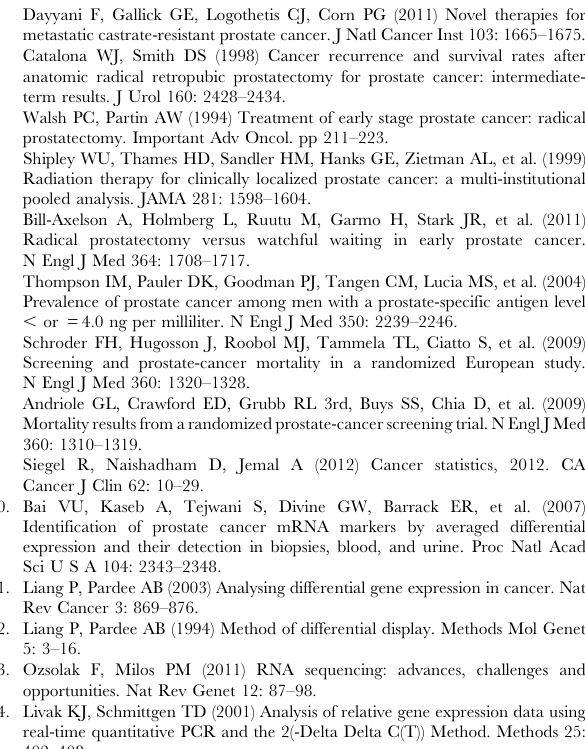
Table S1 Raw C T data are presented for the validation cohorts of prostate cancer patients (PrCa pts) and healthy controls. Mean C T values were lower in PrCa pts compared to controls (28.25 vs. 29.50, p= 0.02). Mean C T values for the 18S reference gene were not statistically different between patients and controls (16.62 vs 16.67, p =0.89). Means were compared using a